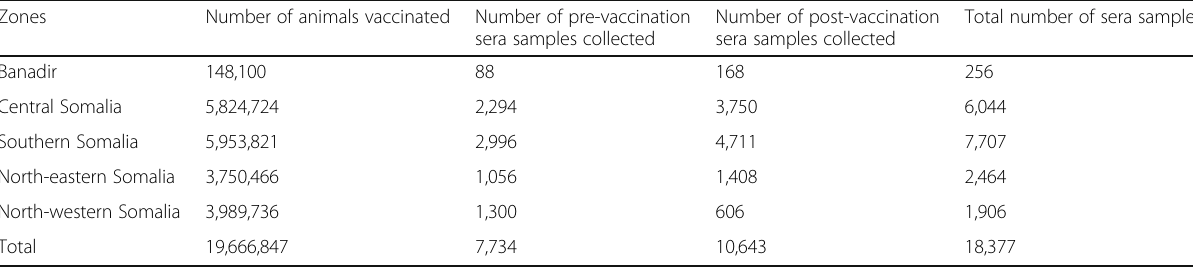
Table 2 Number of serum samples taken before and after PPR vaccination campaigns in Somalia, 2012 Zones Number of animals vaccinated Number of pre-vaccination